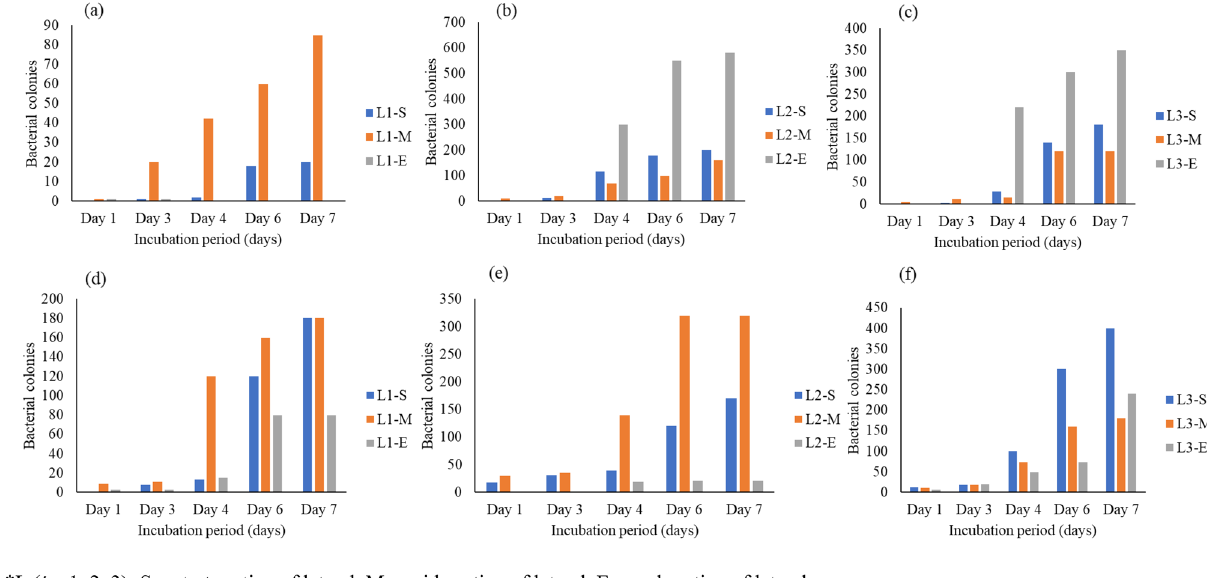
Figure 9. Bacterial colony growth for deposited sediment (DS) under HFCW effluent ( a ) for lateral 1 (L1), ( b ) lateral 2 (L2), and ( c ) lateral 3 (L3). Bacterial growth on adhered bacterial biofilm (ABF) for ( a ) L1, ( b ) L2, and